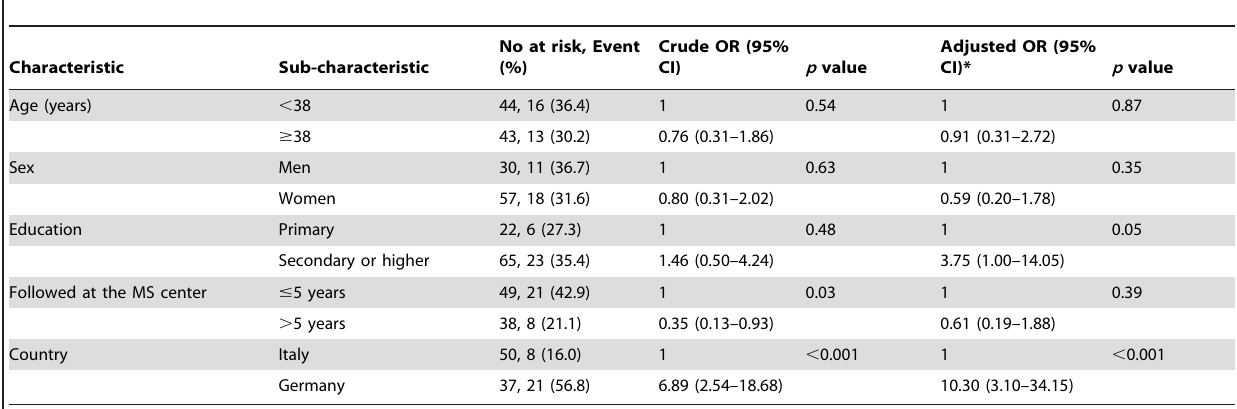
Figure 2. Distribution of role preferences according to administered CPS (face-to-face vs. electronic, eCPS) in 87 MS patients. CPS scores range from 1 (active-active) through 6 (passive-passive). The histograms report numbers of patients with each CPS score, by country (Italy, black; Germany, grey). The bubble plot shows pairs of counts of each score, with larger bubbles corresponding to higher counts. doi:10.1371/journal.pone.0066127.g002 Table 2. Variables associated with active role preference on the eCPS among 87 people with MS in univariate and multivariate models. Age was categorized into two classes, with median as